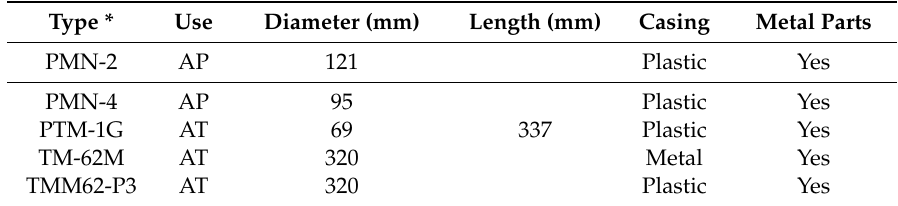
Table 1. Expected mines in